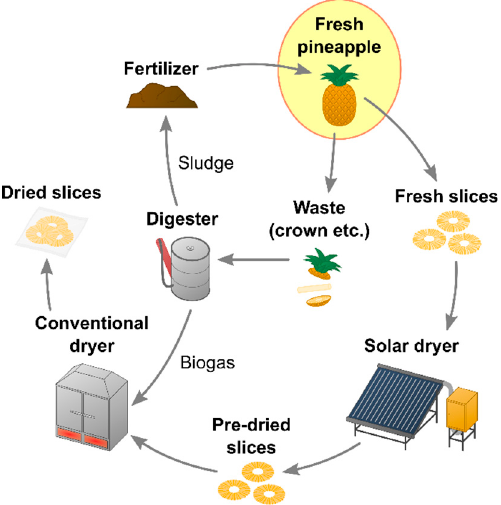
Figure 1. The circular economy principle presented for the example of pineapple processing in Togo.